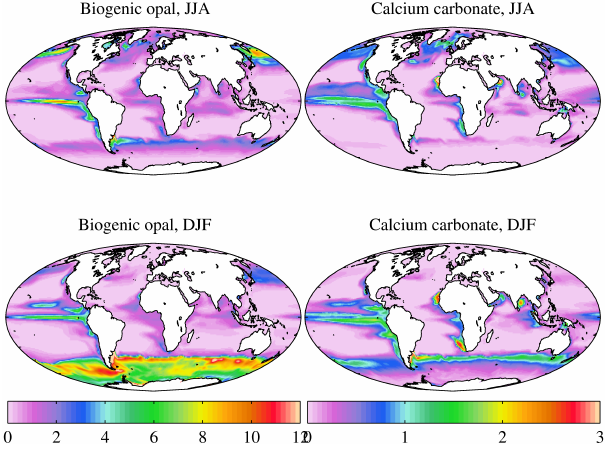
Fig. 31. Simulated diatom biogenic opal (left) and calcium car- Fig. 27. Simulated diatom biogenic opal ( left ) and calcium carbonate ( right ) production for northern summer (June–July–August; top ) and northern winter (December–January–February; bottom ). Biogenic opal production in bonate (right) production for northern summer (June-July-August; top) and northern winter (December-January-February; bottom). Biogenic opal production in mmolSim − 2 d − 1 ; calcium carbonate production in mmolCm − 2 d − 1